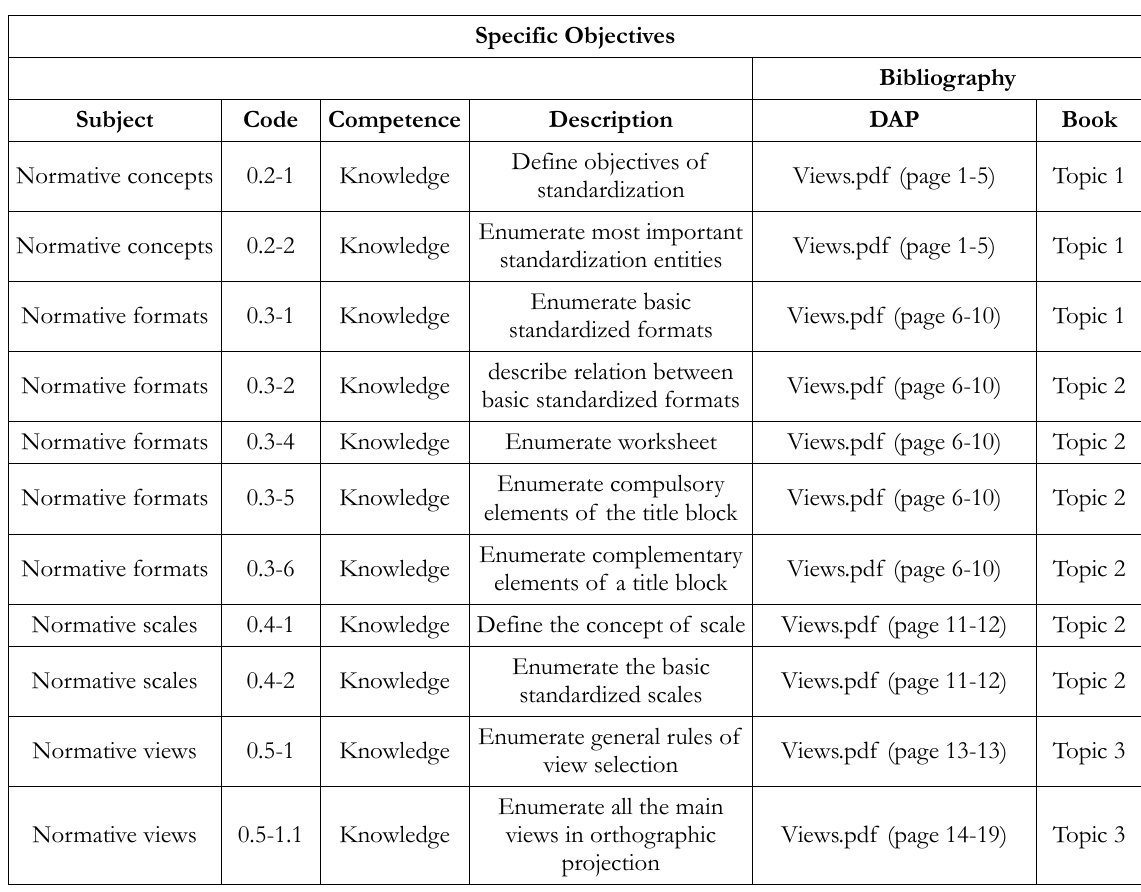
Table 1. Specific objectives detailed in session